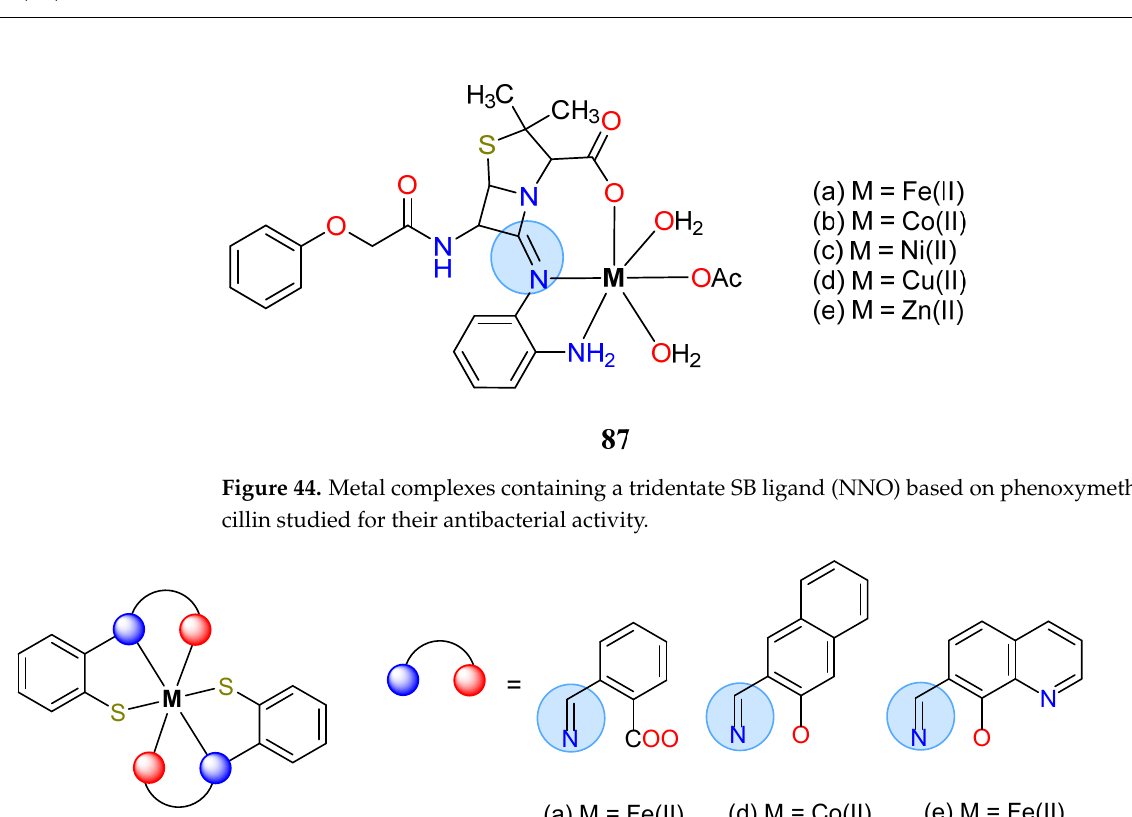
Figure 45. Fe(II), Co(II), and Ni(II) complexes with unsymmetrical tridentate Schiff base ligands prepared from 2 ‐ aminothiophenol with aldehydes.